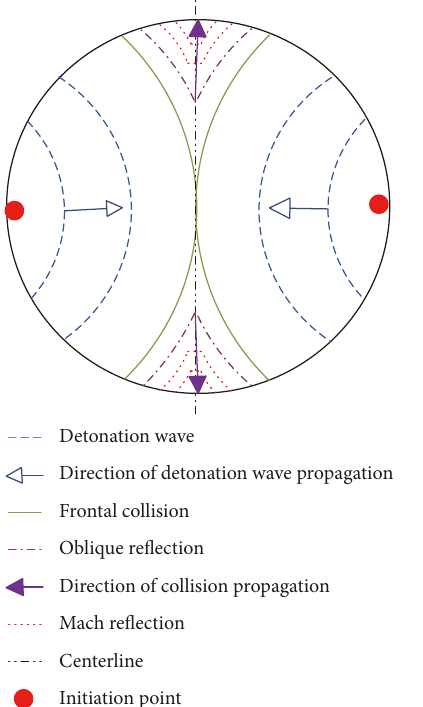
Figure 1: Entire process of detonation wave propagation.